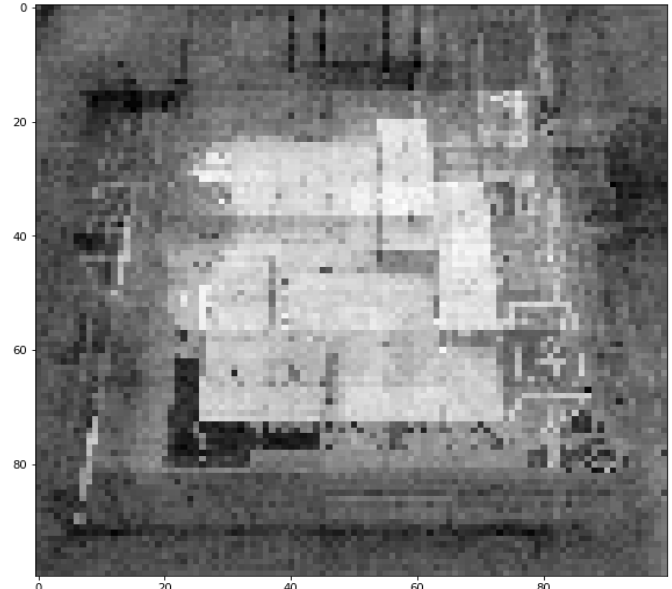
Figure 7. The zoom-in version of an output game map of Arknights after the mixing of several processed images in the VAE model.